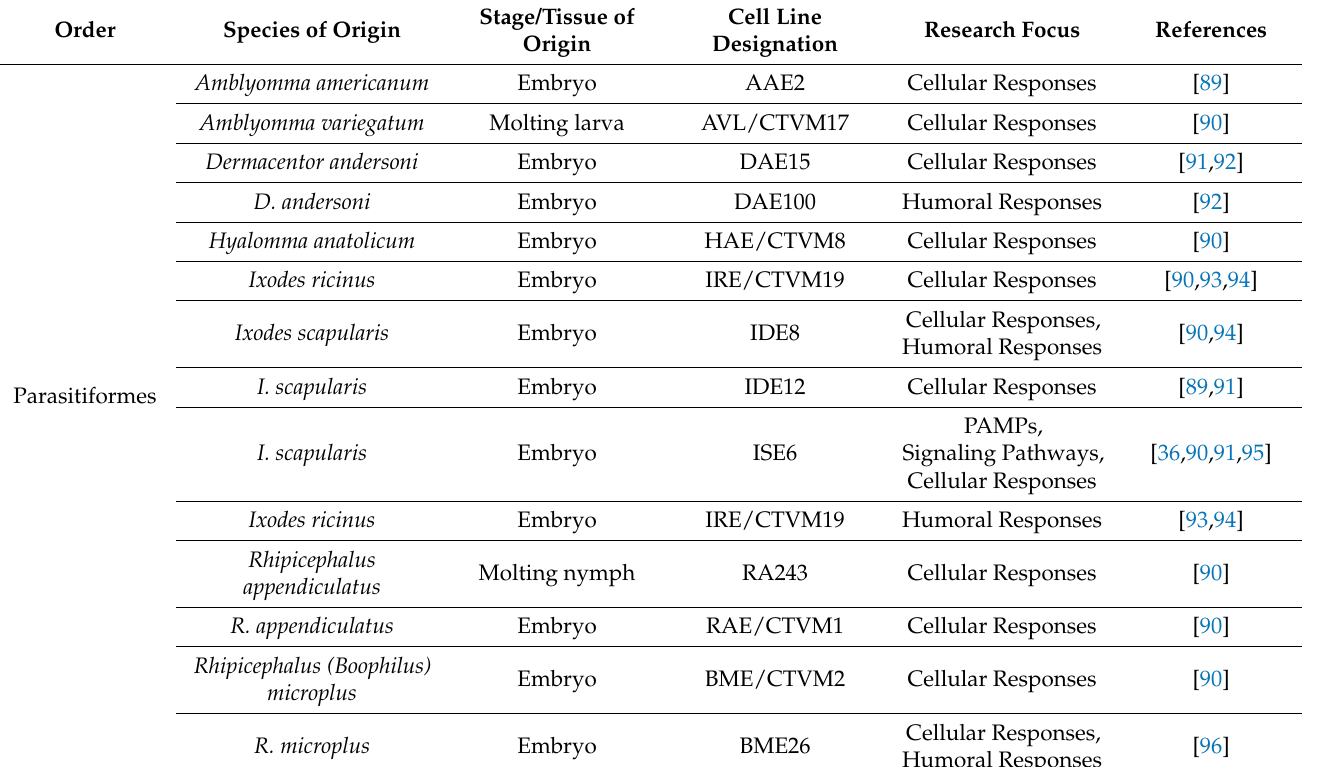
Table 3. Examples of the tick cell lines used in immune-related